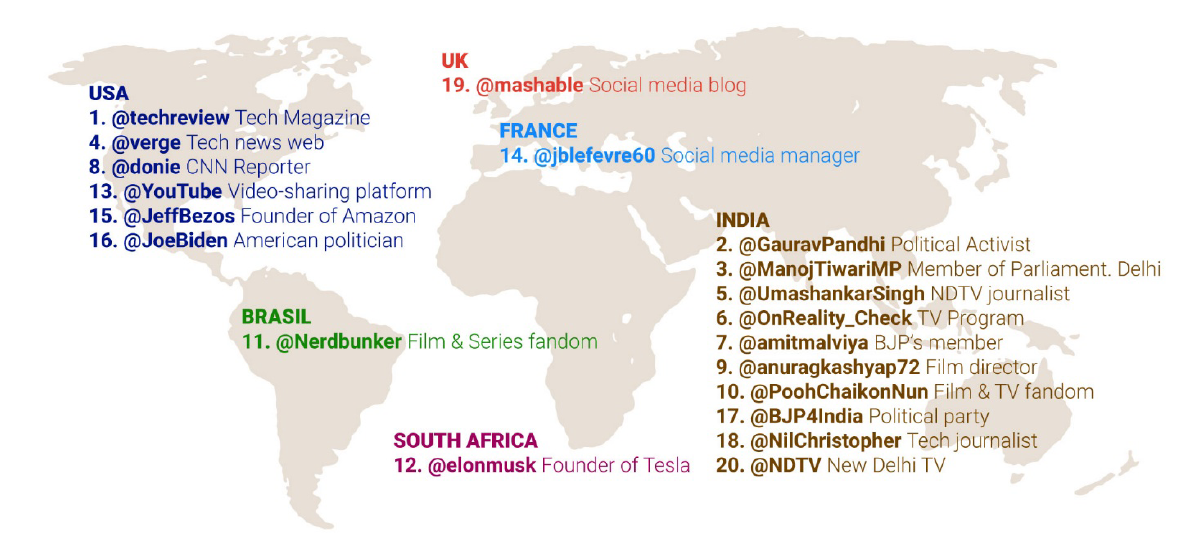
Figure 3. In-degree: Actors most-referenced and viralized by other users. ment website @Nerdbunker and another media out- let